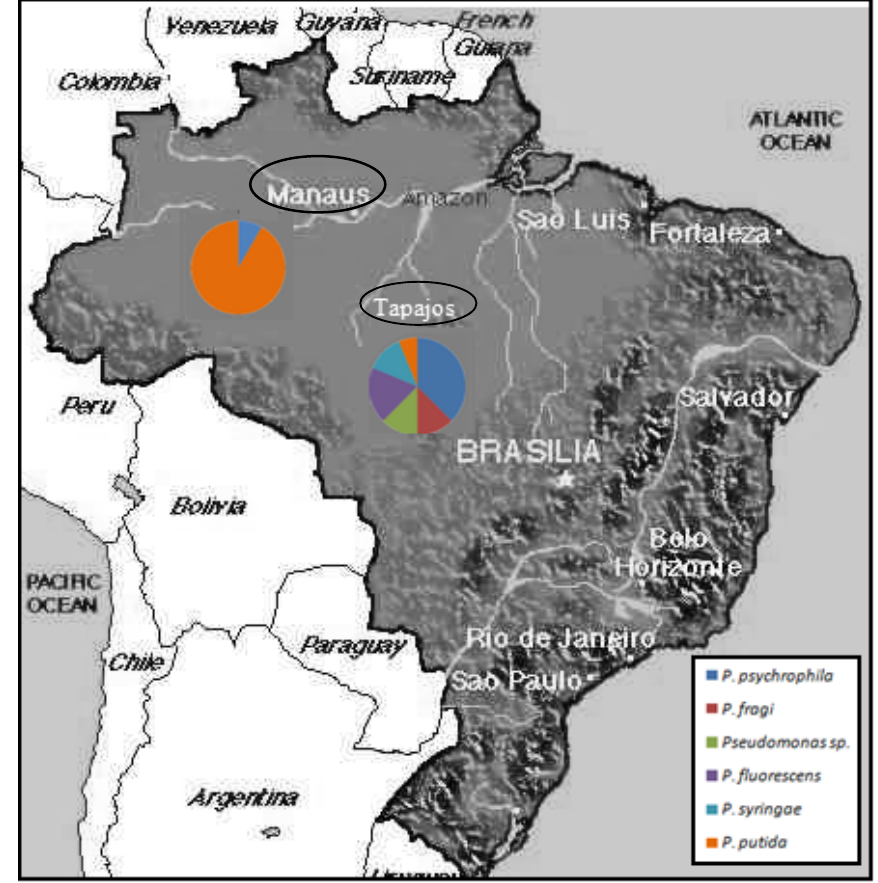
Figure 1. A map with proportions of different Pseudomonas species found in each sampling site: Manaus and